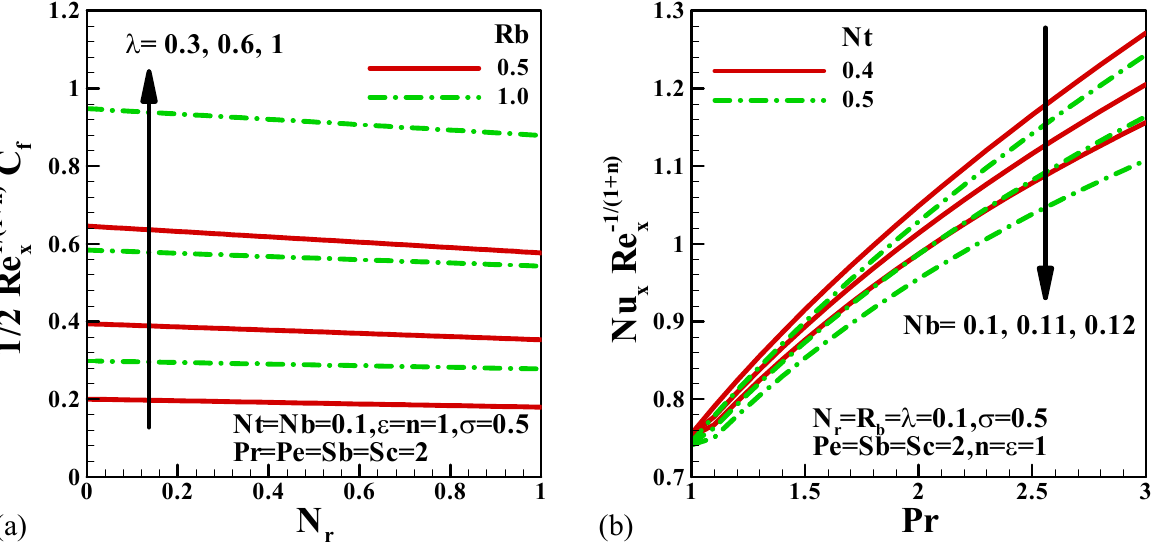
Figure 7. Variation in skin friction with ( a ) buoyancy ratio parameters for different values of biocon- vection Rayleigh number and dimensionless mixed convection parameter and ( b ) variation in the Nusselt number with the Prandtl number for different values of nanofluid parameters.